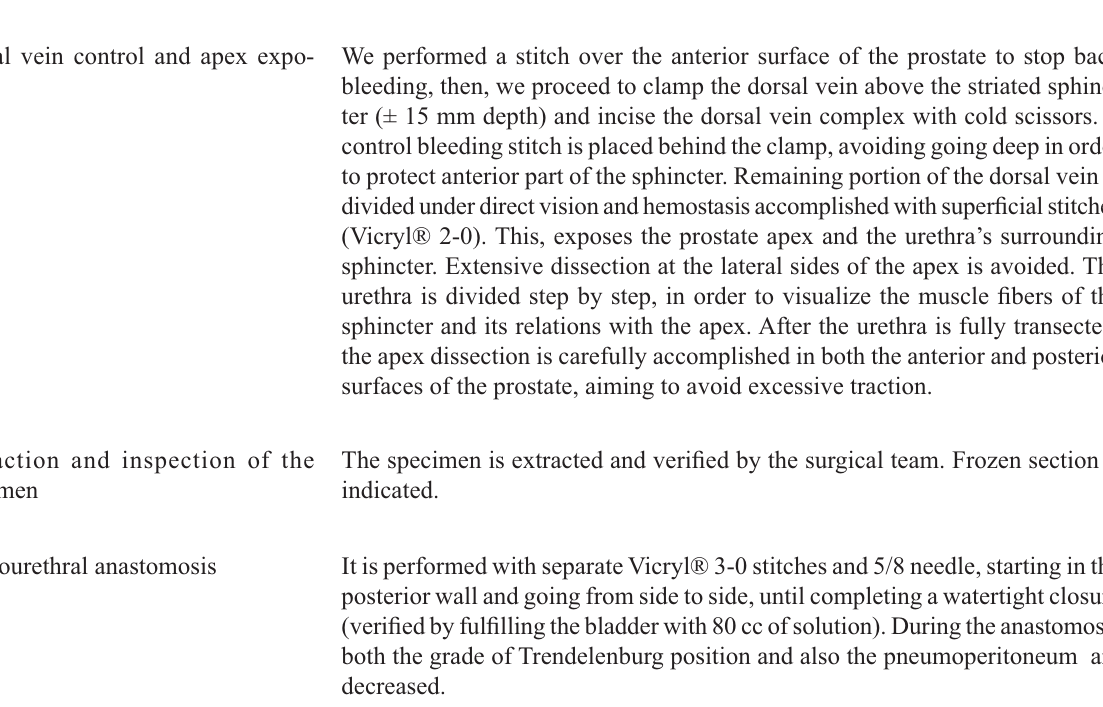
Table 3 – Montsouris technique for laparoscopic radical prostatectomy. ( Dorsal vein control and apex expo-